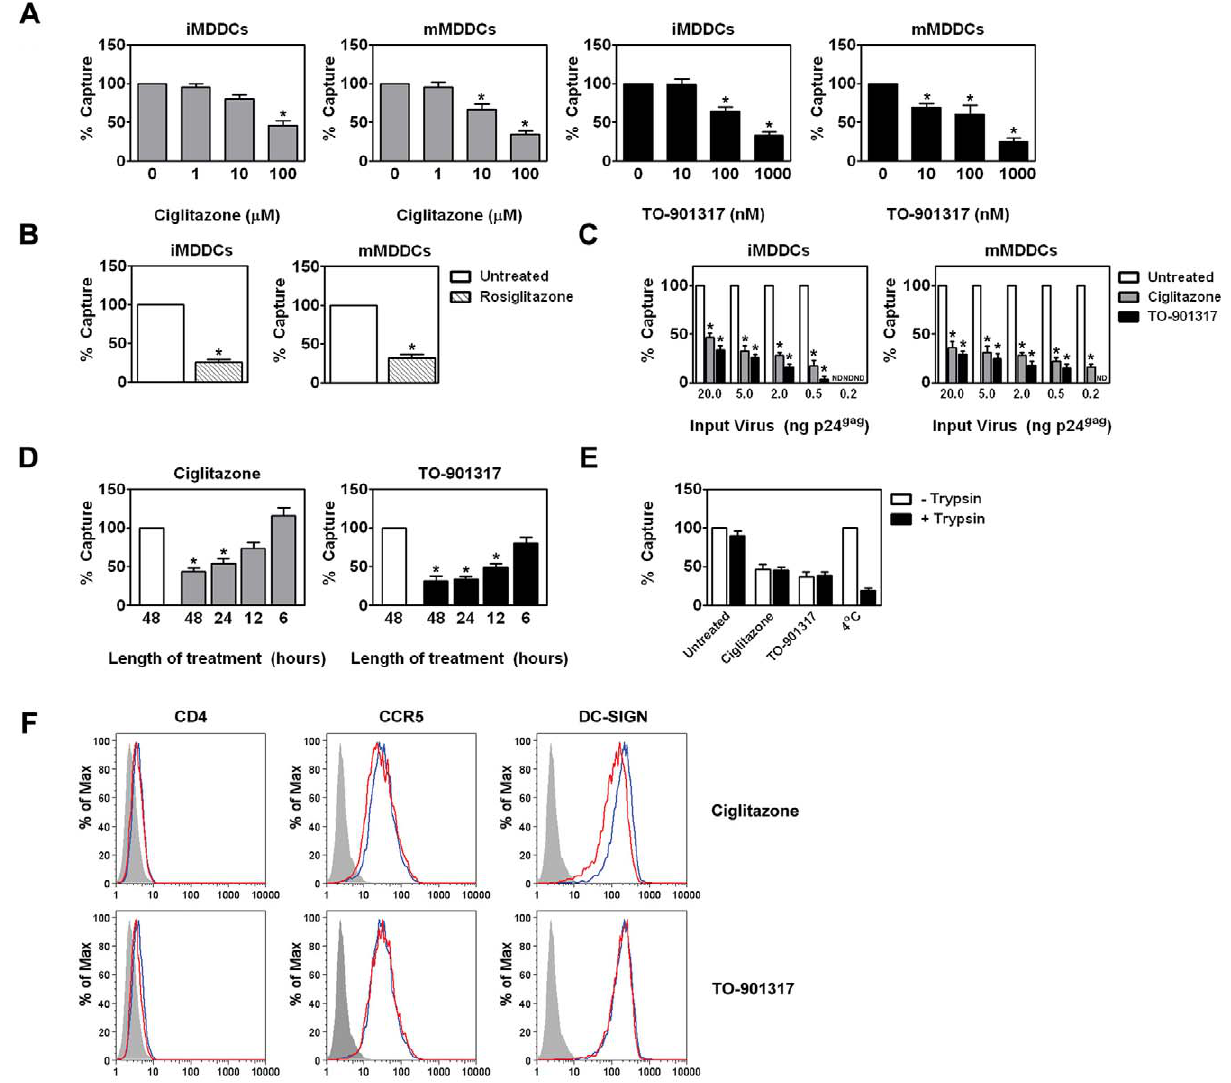
Figure 5. NR ligand treatment prevents HIV-1 trans -infection by blocking the capture of HIV-1 particles by MDDCs. (A) Immature (left panel) and mature (right panel) MDDCs were treated with increasing concentrations of ciglitazone or TO-901317 for 48 hours. The MDDCs were then incubated with 5 ng p24 gag equivalent of HIV-1 ADA and virus capture was measured by p24 gag ELISA. Mean capture values: 622.93 pg p24 gag for untreated iMDDCs; and 1.80 ng p24 gag for untreated mMDDCs. (n=4) (B) Immature (left panel) and mature (right panel) MDDCs were treated with 1 m M rosiglitazone (hatched bars) for 48 hours and analyzed as in (A). (n=3) (C) Immature (left panel) and LPS-matured (right panel) MDDCs were treated for 48 hours with 100 m M ciglitazone or 1 m M TO-901317 and incubated with increasing amounts of HIV-1 ADA , washed extensively, and lysed. Virus capture was measured by p24 gag ELISA. (n=3) (D) iMDDCs were treated with 100 m M ciglitazone or 1 m M TO-901317 for various times, incubated with HIV-1 ADA , and assayed for virus capture by p24 gag ELISA. (n=3) (E) Immature MDDCs were treated with ciglitazone (100 m M) or TO-901317 (1 m M) for 48 hours, incubated with HIV-1 ADA for four hours at 37 u C, and then washed to remove unbound virus. Some cells were incubated with virus at 4 u C (as indicated). The cells were then treated with 0.5% trypsin for 5 minutes at 37 u C to degrade surface-bound virus particles, washed twice in culture medium, and lysed as above. Virus capture was measured by p24 gag ELISA. (n=3) (F) iMDDCs were treated with either 100 m M ciglitazone or 1 m M TO-901317 for 48 hours and cell-surface expression of CD4, CCR5, and DC-SIGN was measured by flow cytometry. Shaded histogram, isotype control. Blue line, iMDDCs. Red line, nuclear receptor ligand-treated iMDDCs. * p , 0.001 compared to untreated controls, ND, not detected.